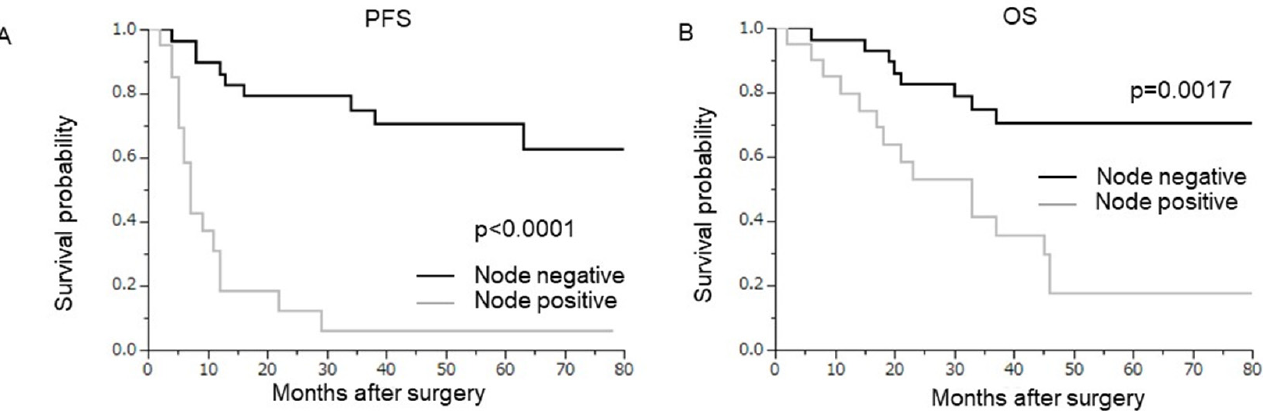
Figure 2. Prognostic significance of the number of lymph node metastases in node-positive patients. Kaplan–Meier estimates of survival according to the number of lymph nodes (1–2 ( n = 10) versus ≥ 3 ( n = 11)). Survival rates of the node-negative group ( n = 29) are also provided as references. ( A ) Progression-free survival (1–2 versus ≥ 3, p = 0.7736). ( B ) Overall survival (1–2 versus ≥ 3, p = 0.5229). 3.3. Prognostic Significance of the Location of Lymph Node Metastases Of the 21 patients with lymph node metastasis, 15 had metastasis in the PLN and 6 had PLN+PALN metastasis (Table 1). Isolated PALN metastasis was not observed. A com- parison of the clinicopathological characteristics between the two groups (PLN vs. PLN+PALN) revealed no significant differences in patient characteristics (Supplemental Table S4). As shown in Figure 3, the survival of patients with PLN metastases was equiv- alent to that of patients with PLN+PALN metastases (PFS, p = 0.7556; OS, p = 0.9464).